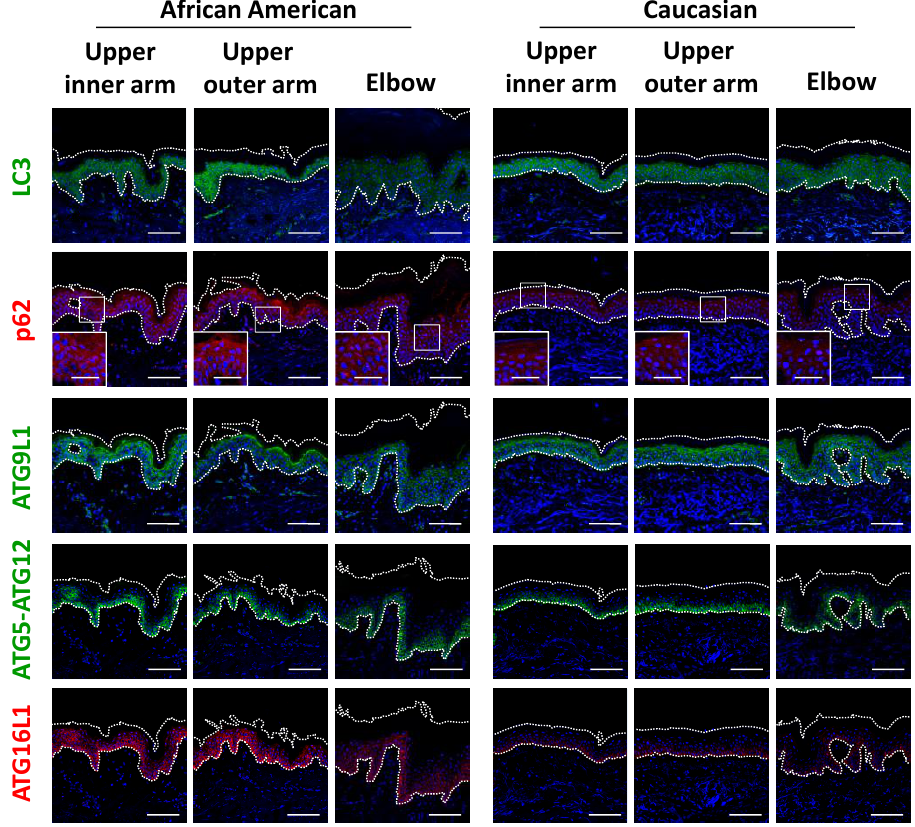
Figure 5. Impaired autophagy proteins in hyperpigmented skin. (a) Skin tissues from upper inner arm, upper outer arm and elbow regions of AA and Caucasian subjects were subjected to immunofluorescent analysis. Merged images of LC3 (green), p62 (red), ATG9L1 (green), ATG5-ATG12 (green) or ATG16L1 (red), and DAPI nuclear staining are presented. Lower insets show magnification of areas inside white rectangles. Bars = 100 μm or 50 μm (insets).